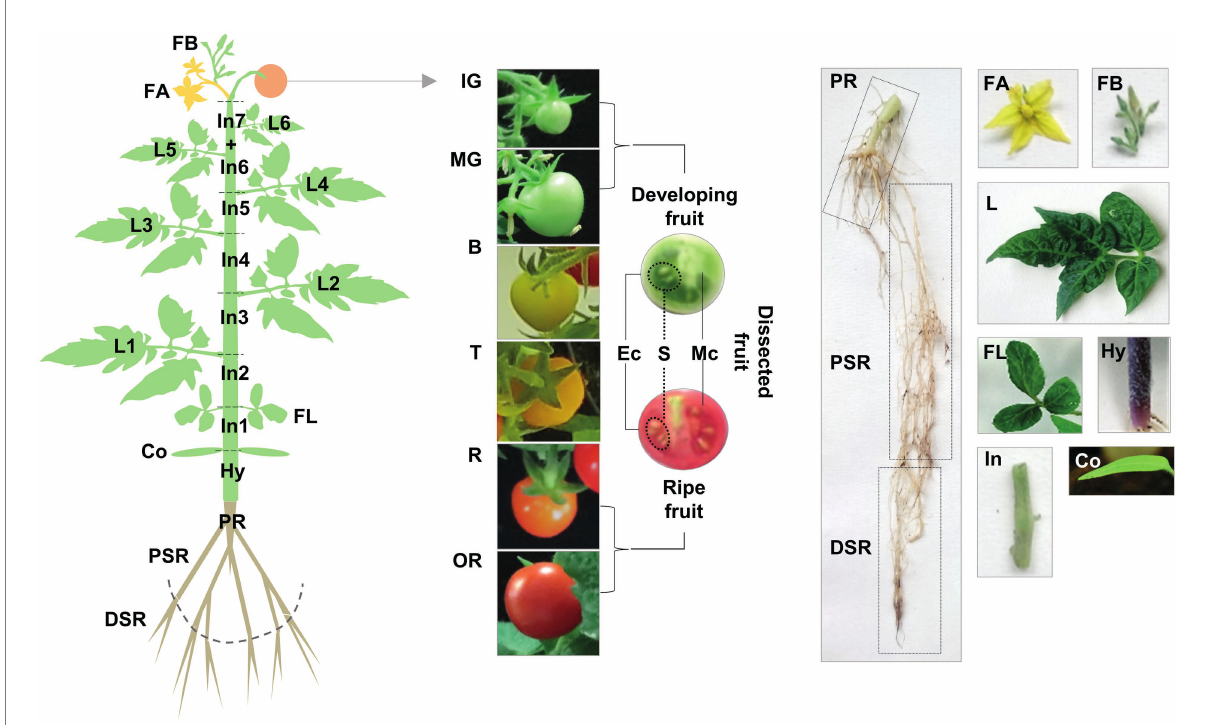
FIGURE 3 Schematic representation of our sampling strategy for gene expression profiling and targeted metabolomics. Vegetative organs: roots (PR, primary root; PSR, proximal secondary root; DSR, distal secondary root), stem (Hy, hypocotyl; In, internode), cotyledons (Co), leaves (FL, first leaves; L, true leaves). Reproductive organs: flowers (FB, flower buds; FA, flowers at anthesis), fruit (IG, immature-green; MG, mature-green; B, breaker; T, late breaker/turning; R, ripe; OR, over-ripe), dissected fruit (Ec, exocarp; Mc, mesocarp; S,